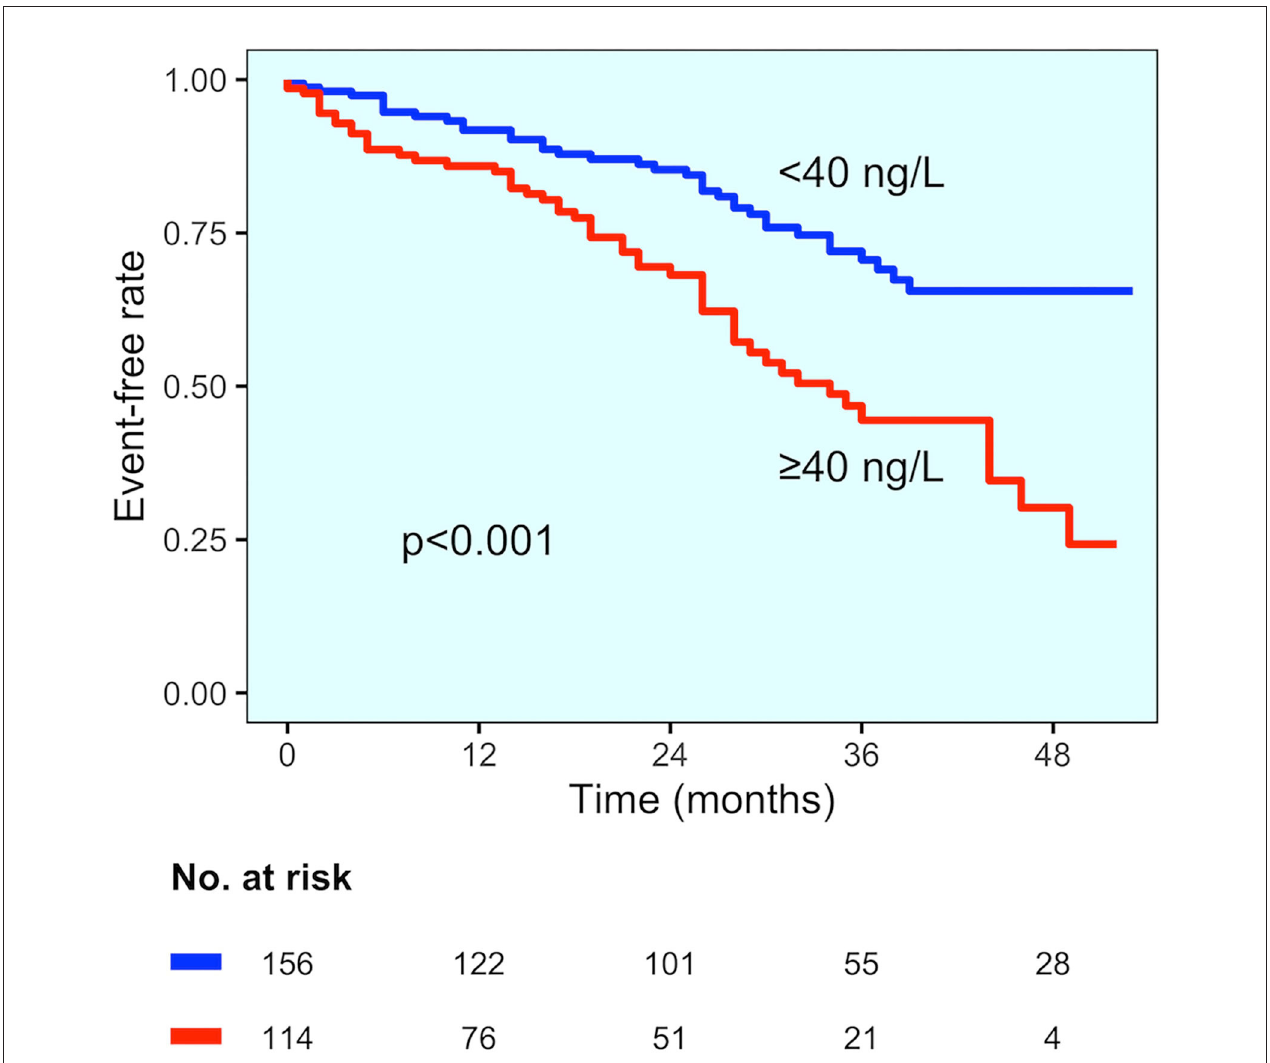
FIGURE 3 | MACE incidence in the established CAD diagnosis group. Kaplan–Meier curves for MACE in patients with established CAD diagnosis, stratified by hs-TnT cut-off (40